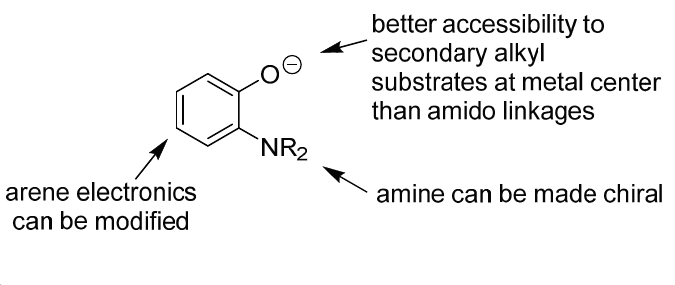
Figure 1. The potential utility of aminophenolate ligands for cross-coupling reactions.